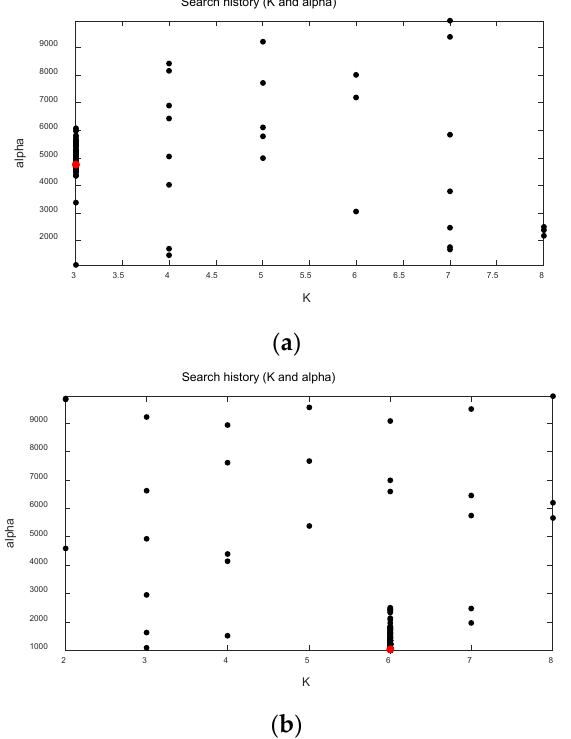
Figure 4. Search history (K and alpha): ( a ) Historical value for the BRST station; ( b ) historical value for the HKQT station.